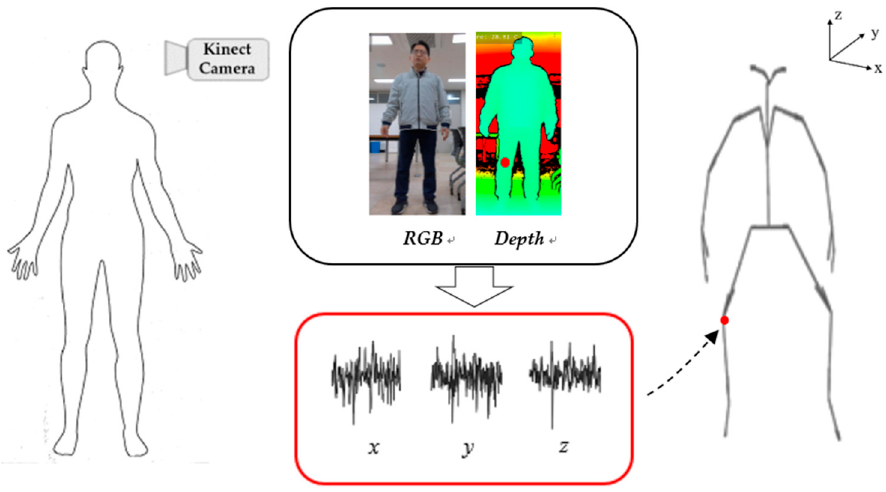
Figure 2. Concept of skeleton joints composed using the RGB + D camera for the 3D skeleton esti- mation.